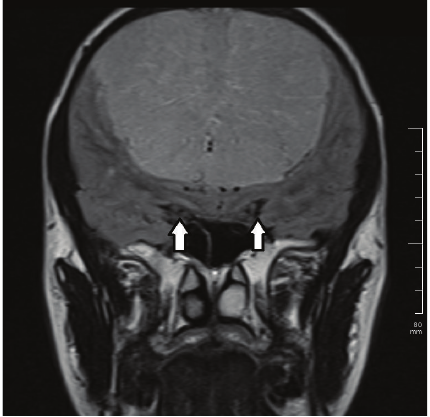
Figure 4: Magnetic resonance imaging. Coronal T2-weighted ima- ges show that the mass was exerting pressure on the